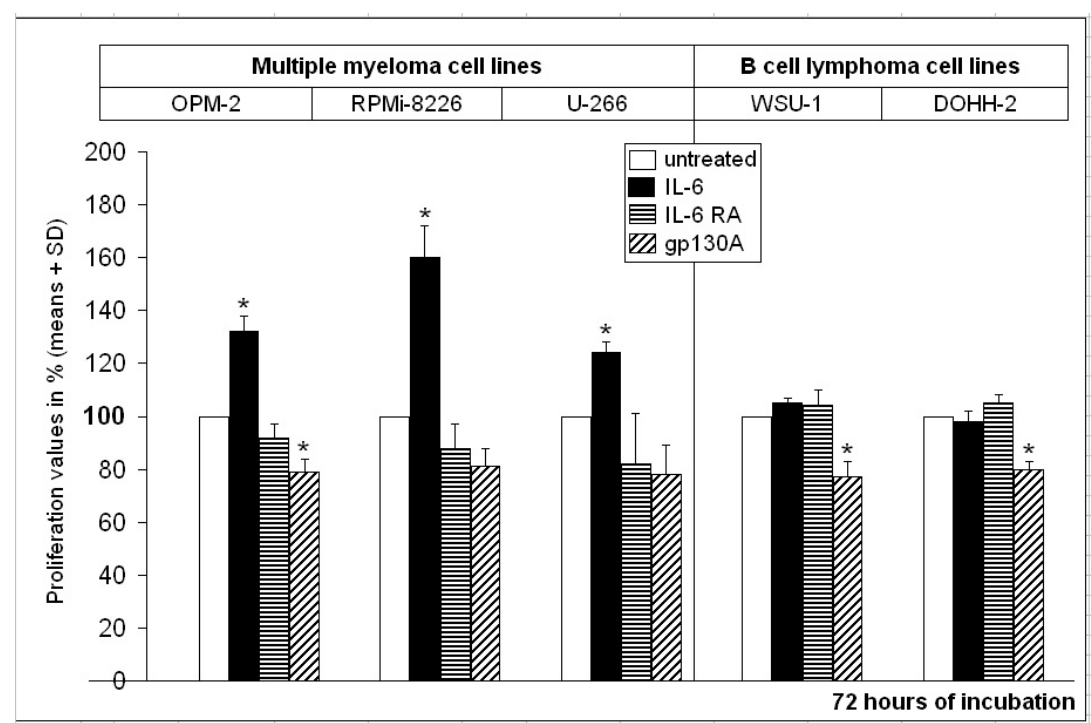
FIGURE 2. The proliferative response of human tumour cell lines to IL-6, IL-6RA, or gp130A. The cells were incubated with IL-6 (0.5 ng/10 5 cells/100 µl) for 72 h or with IL-6RA (0.02 µg/10 5 cells/100 µl), or gp130A (1 μ g/10 5 cells/100 μ l) for 24 h after 48 h of cultivation. The proliferation was measured by WST-1 reagent. The results of three or four independent experiments (mean + SD) are expressed as percentage of the untreated samples. * p < 0.05 (Mann Whitney U-test) vs. untreated.